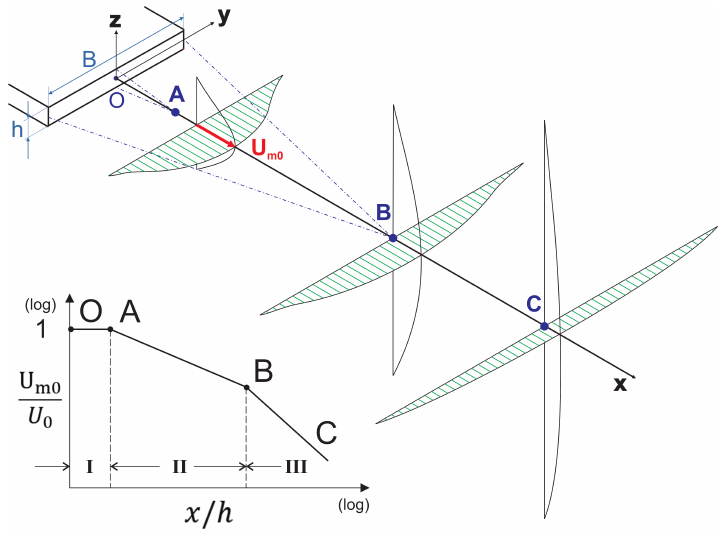
Figure 1. Sketch of a rectangular jet. B : nozzle width, h : nozzle height, x , y , z : distance from a suitable origin, U 0 : the velocity efflux, U m 0 : centerline velocities of cut sections. Adapted with permission from Ref. [1] 1976 Elsevier Science & Technology